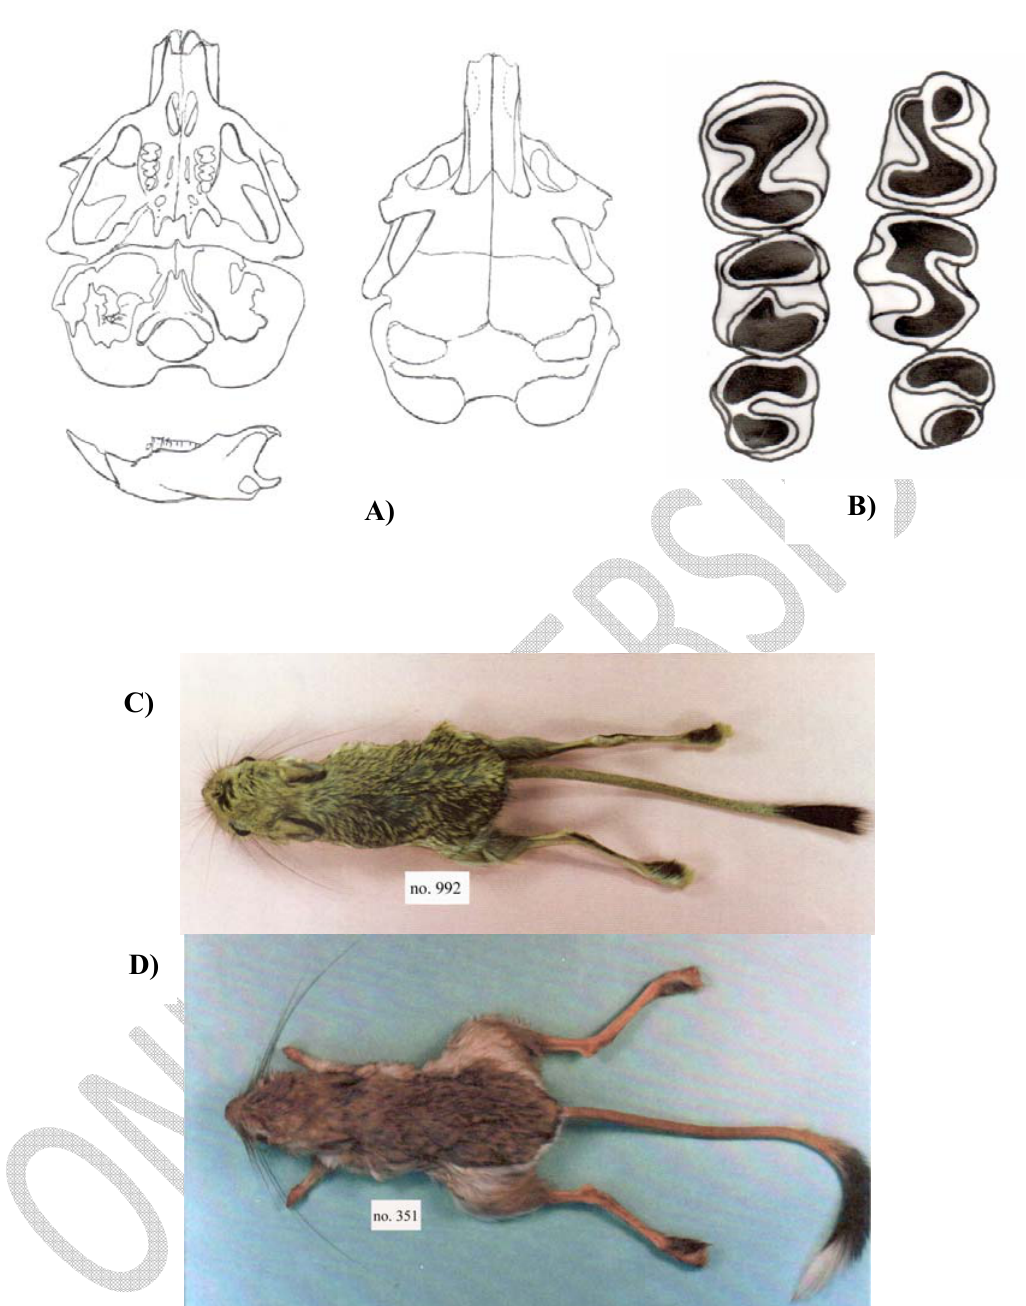
3._ Skull (A)and molras (B) of Jaculus thaleri and F IG . Dorsal view of J. thaleri (C) and J.blanfordi